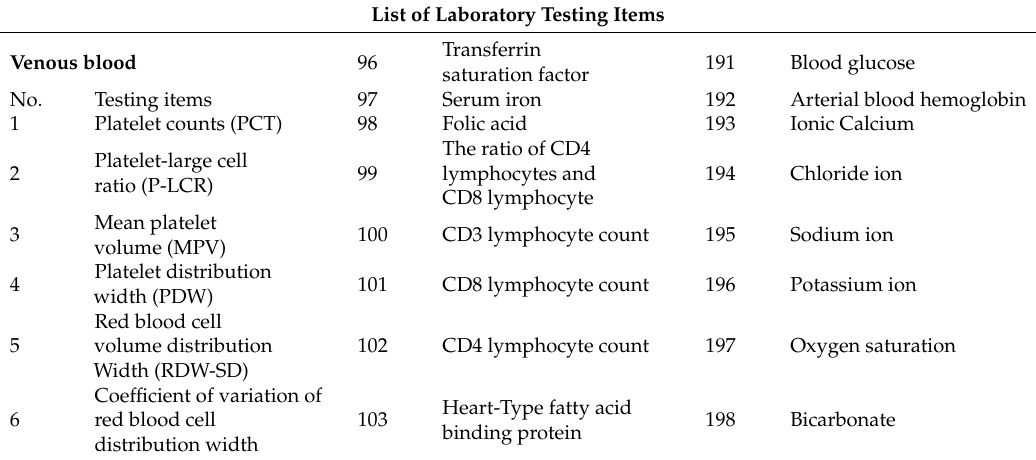
Table A1. List of laboratory testing